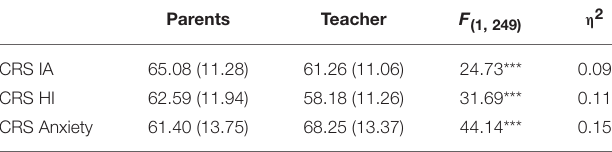
TABLE 1 | Mean standard scores of parent and teacher ratings on CRS subdomains.